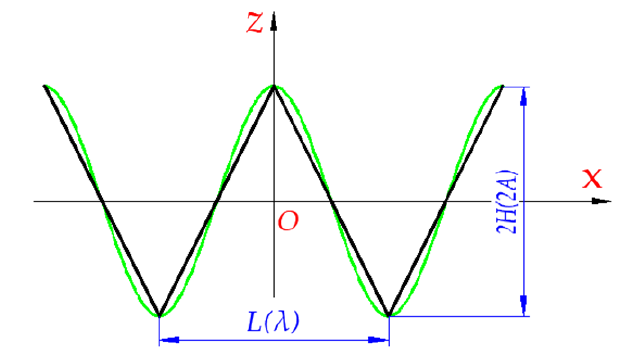
Figure 2. Triangle and cosine wrinkle shape.